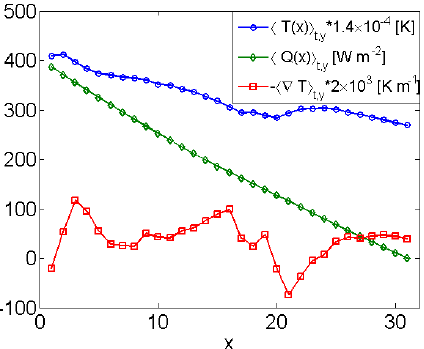
Figure 17. Averaged (in t and y ) profiles calculated using Topos– Chronos for rank k = 1, for temperature (blue), heat flux (green), and negative temperature gradient (red).